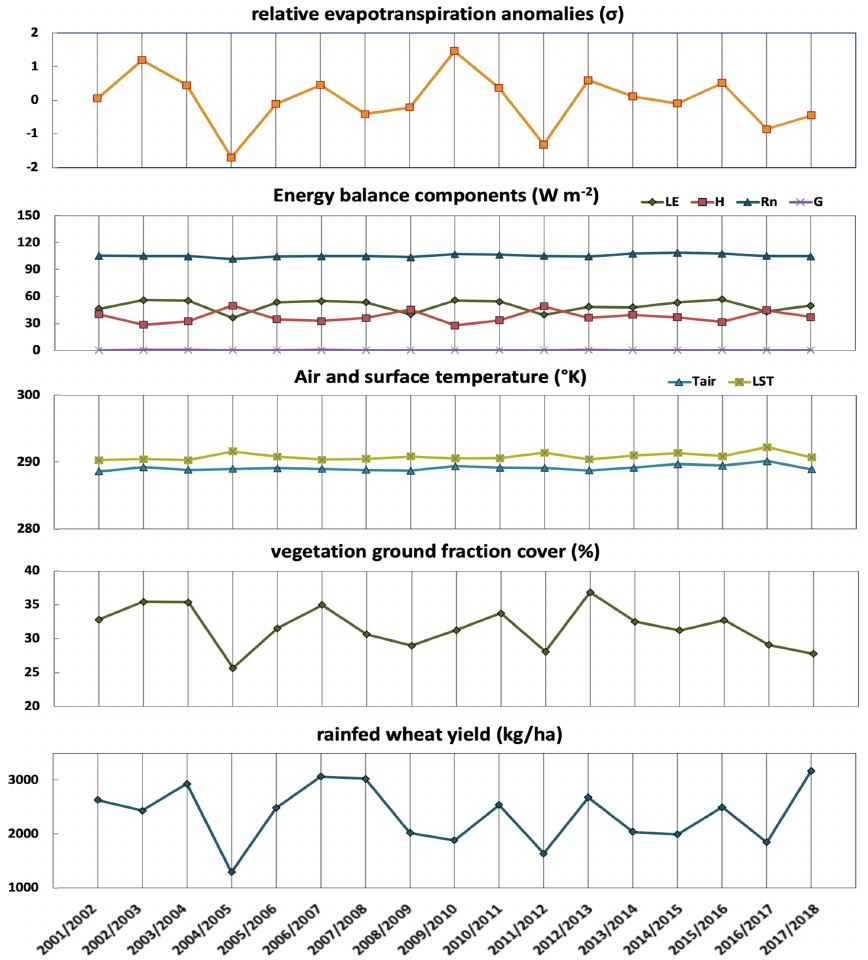
Figure 5. Evolution from 2001/2002 to 2017/2018 of annual anomalies of relative evapotranspiration, energy balance components, air and surface temperature, vegetation ground fraction cover and rainfed wheat yield, aggregated for the whole oak savanna area of the Iberian